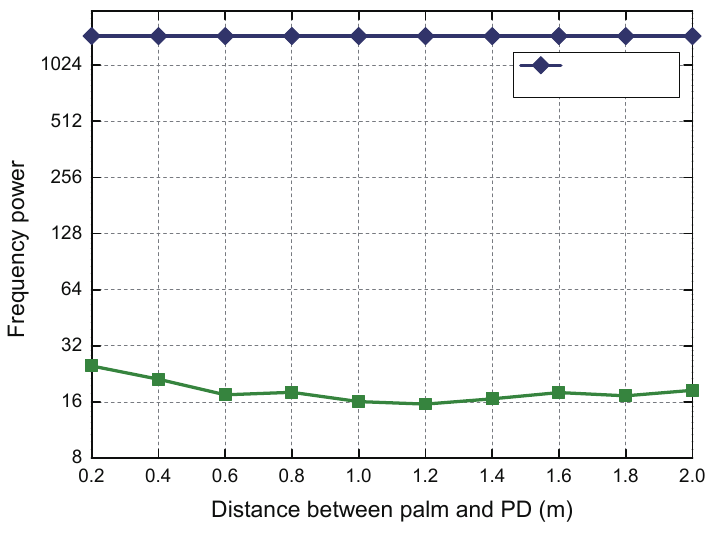
Figure 13. Different distances between palm and